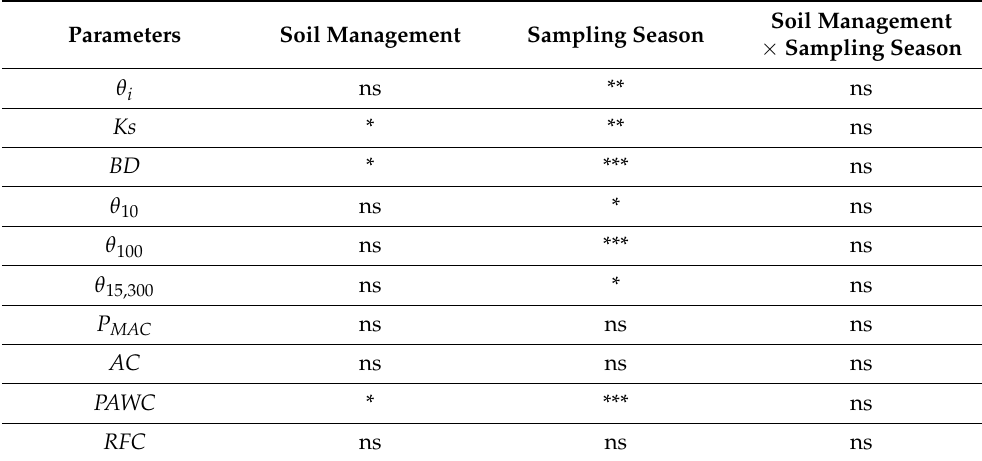
Table 1. Combined ANOVA carried out on soil management and sampling season for physical and hydraulic soil properties and capacity-based indicators.